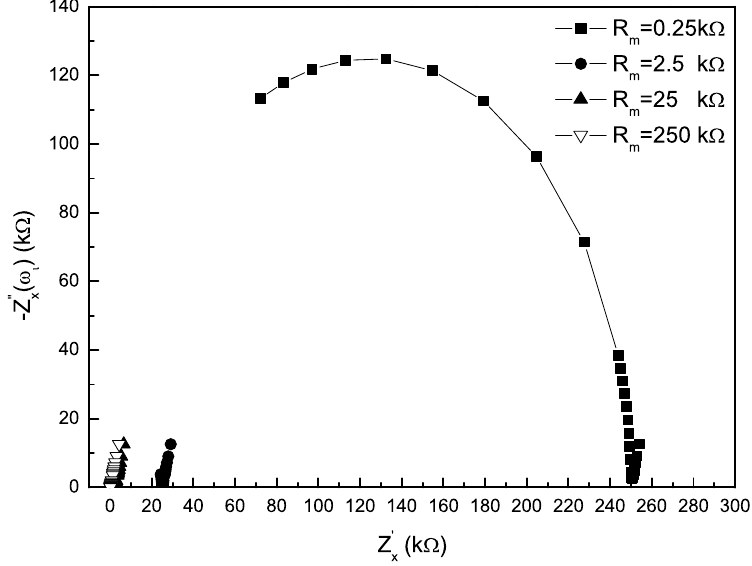
Figure 2. Nyquist plot of the impedance Z x for known